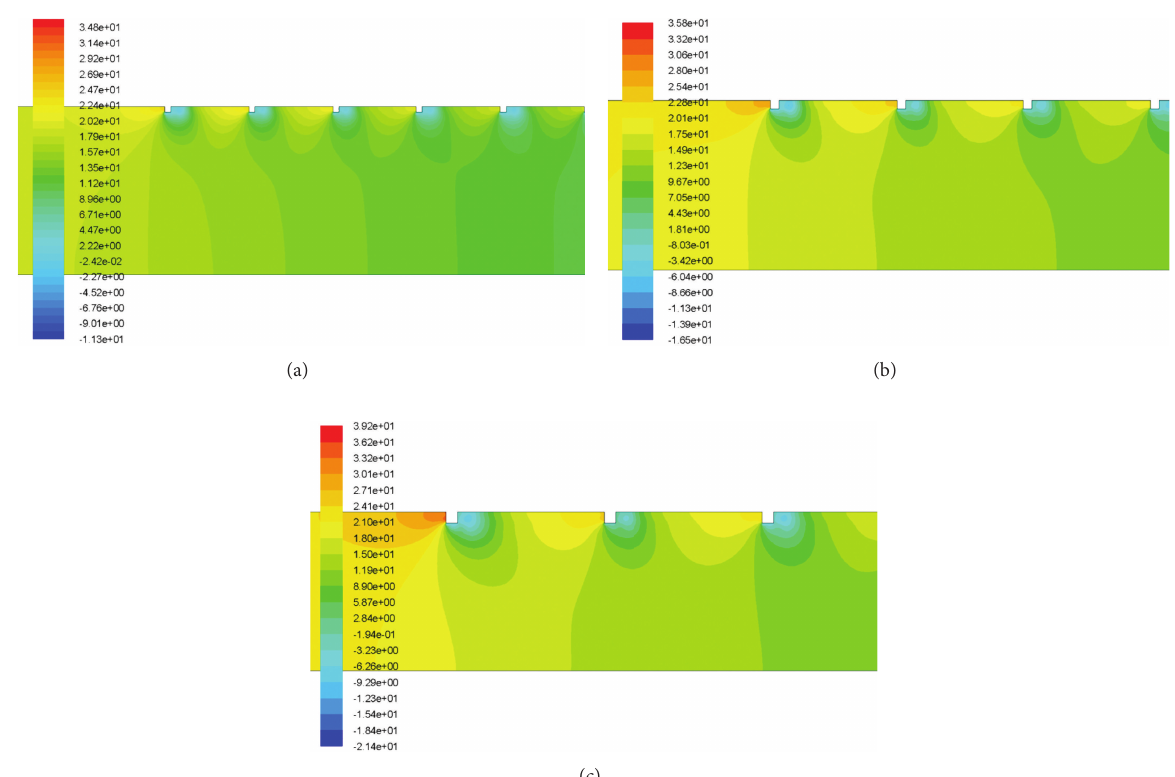
Figure 11: The contour plot of pressure for Re = 18,000 and 𝑃/𝑒 = 14.29 at a relative roughness height of (a) 𝑒/𝐷 = 0.03 , (b) 𝑒/𝐷 = 0.042 and (c) 𝑒/𝐷 = 0.06